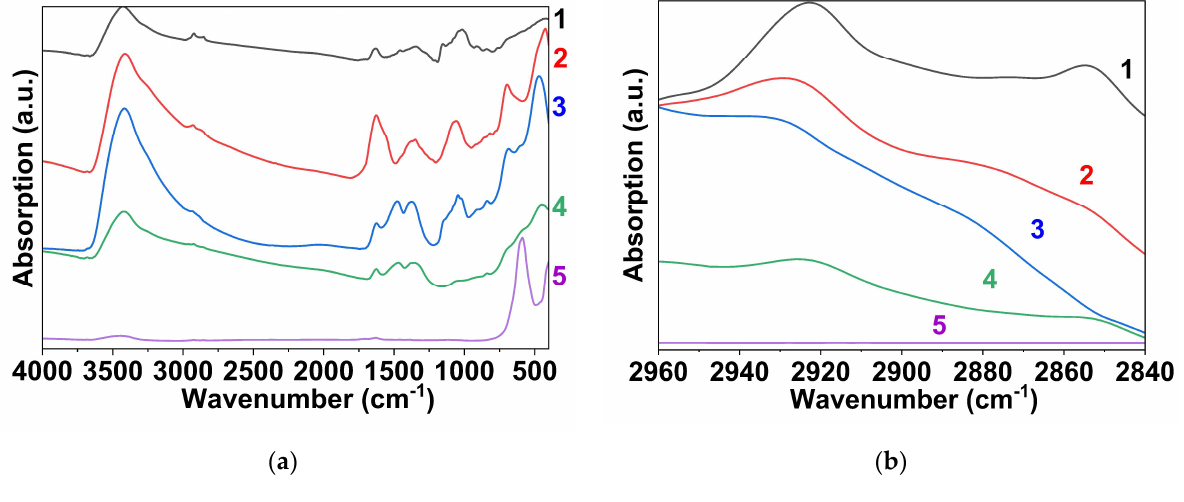
Figure 3. FTIR spectra in the spectral regions of 4000−500 cm −1 ( a ) and 2960−2840 cm −1 ( b ) of the as-prepared samples obtained using dextran-40 (1), inulin (2), dextran-70 (3), and without polysaccharides (4) and of sample 2 (Table 1) with dextran-40 additive calcined at 800 °C (5).